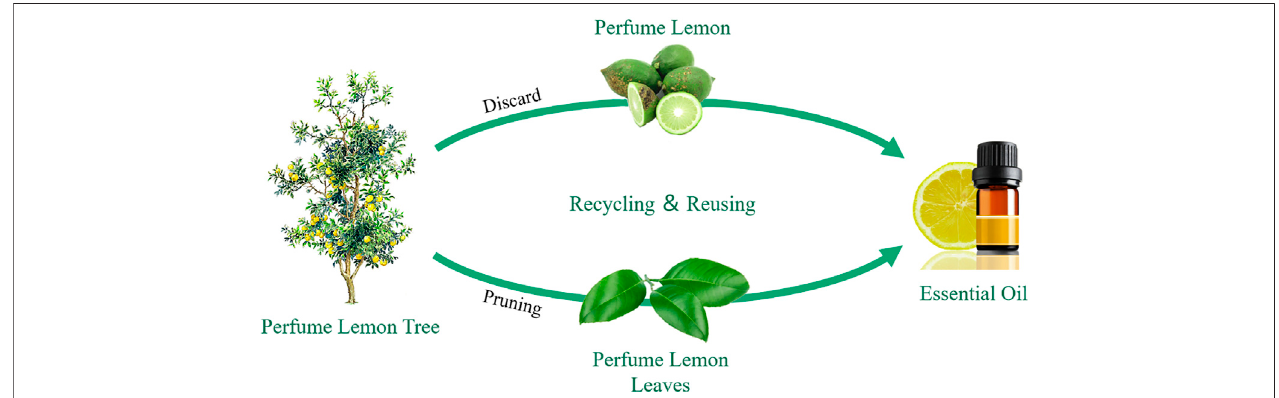
FIGURE 1 | Recycling and reusing of the discarded perfume lemon and